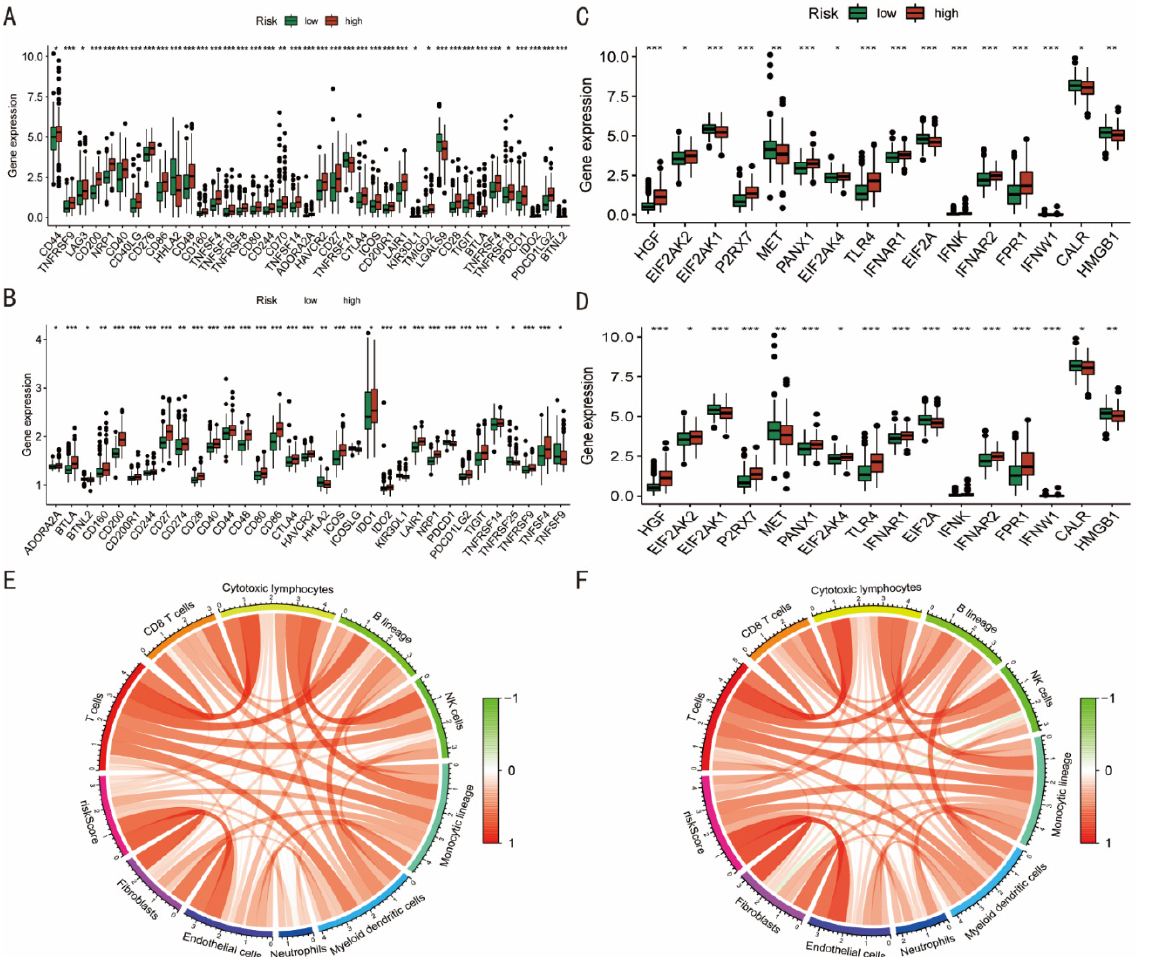
Figure 5. Immune infiltration analysis. ( A , B ) Most immune checkpoints-related genes were up-expressed in the pyroptosis-related high-risk group than low-risk group. ( C , D ) Immunogenic cell death-related genes mainly showed up-expression in the high-risk group. * 0.05; ** 0.01; *** 0.001. ( E , F ) The riskScores of the model were positively correlated with these immune cells.